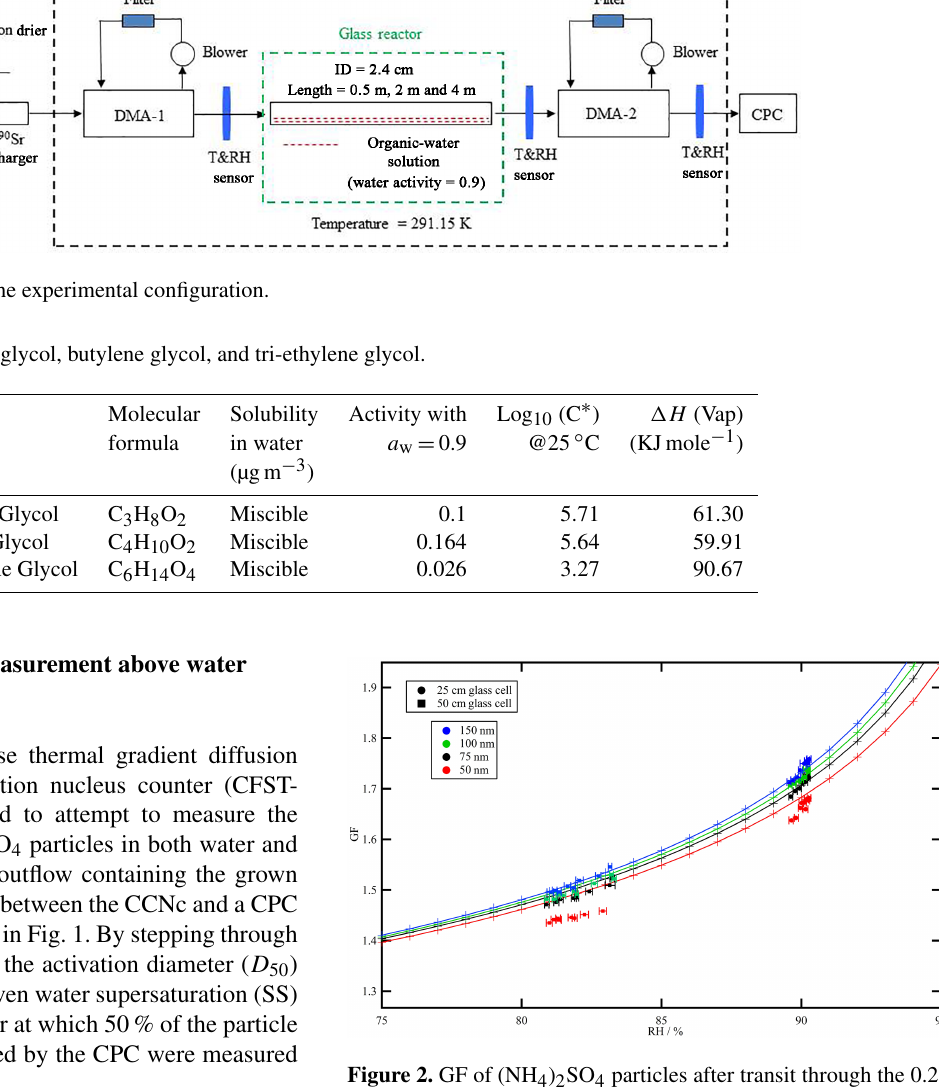
Figure 2. GF of (NH 4 ) 2 SO 4 particles after transit through the 0.25 and 0.5m glass reactors containing NaCl-H 2 O solution with the wa- ter activity at